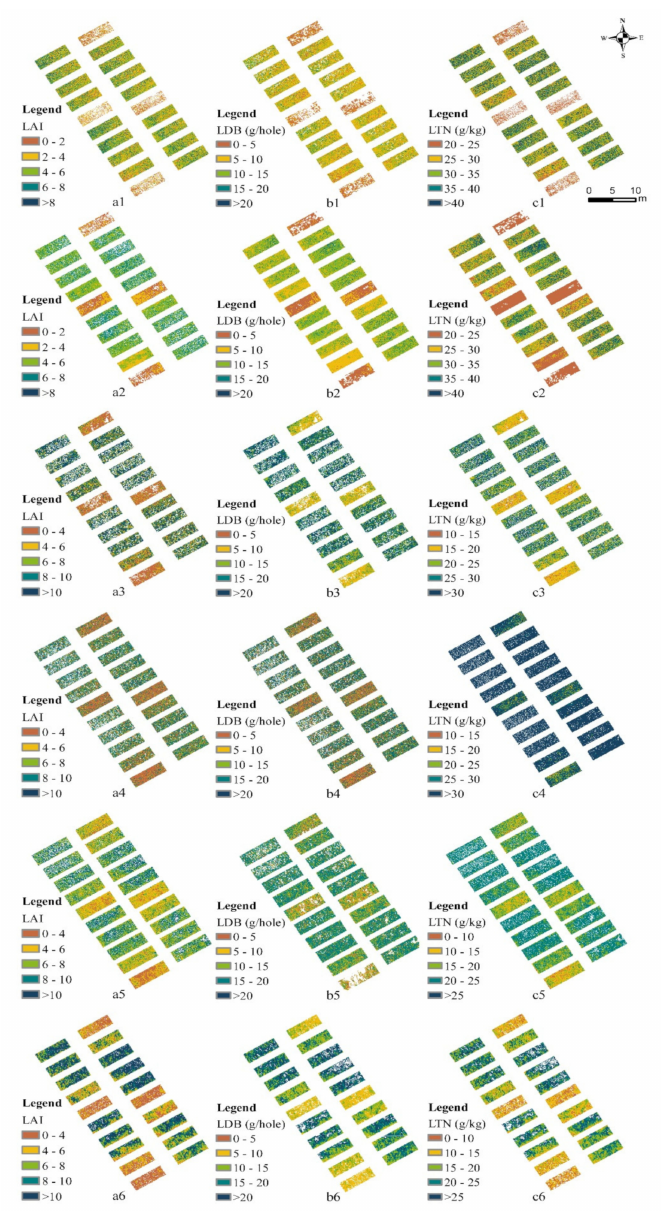
Figure 4. Estimated maps of the key monitoring indicators at di ff erent growth stage. LAI, LDB, and LTN at the tillering stage ( a1 , b1 , c1 ), early jointing stage ( a2 , b2 , c2 ), late jointing stage ( a3 , b3 , c3